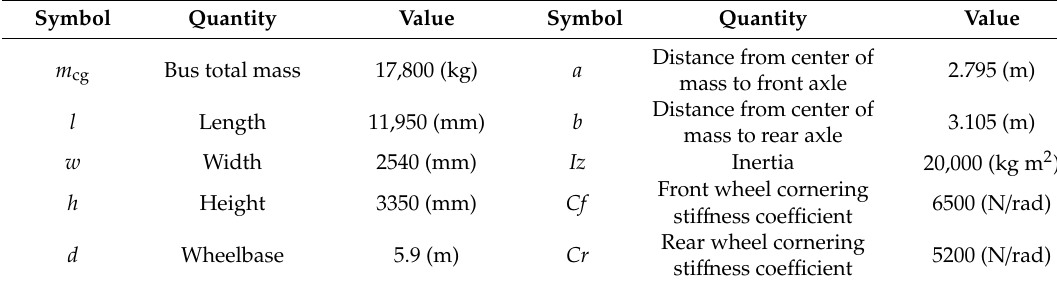
Figure 4. Driverless bus platform. Table 1. Parameters of driverless